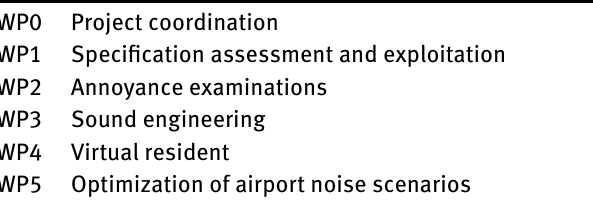
Table 1: The COSMA work